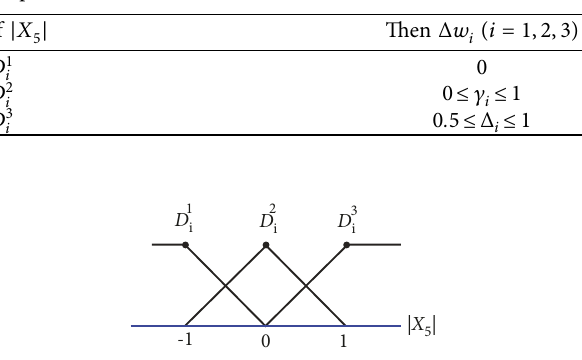
Table 2: Fuzzy rules related to FFSs of the fuzzy system inputs for the cart-pole